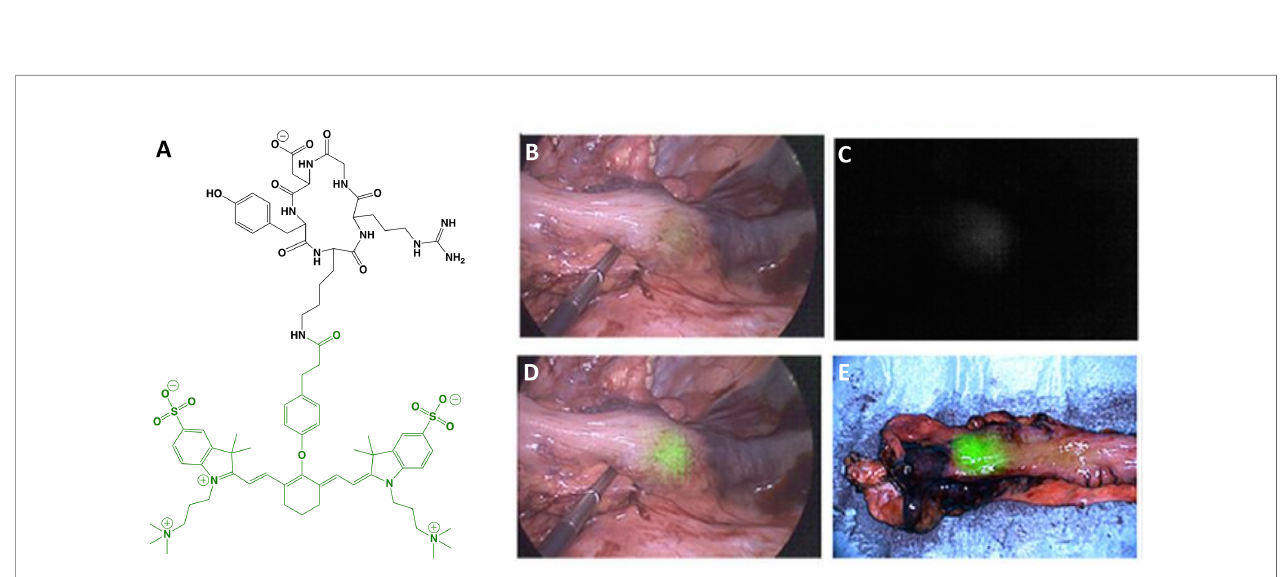
FIGURE 4 | BBN-IRdye800CW. Chemical structure; BBN(7-14) (ligand) and NOTA (Chelator) in black, IRdye800CW (dye) in green (A) . Intraoperative glioblastoma multiforme imaging with 1 mg total BBN-IRdye800CW administered 16 h prior to surgery: NIRF prior to resection (B) , residual fl uorescence after initial tumor removal (C) and tumor-cavity after complete resection (D) . Panels (B – D) are adapted from (53) with